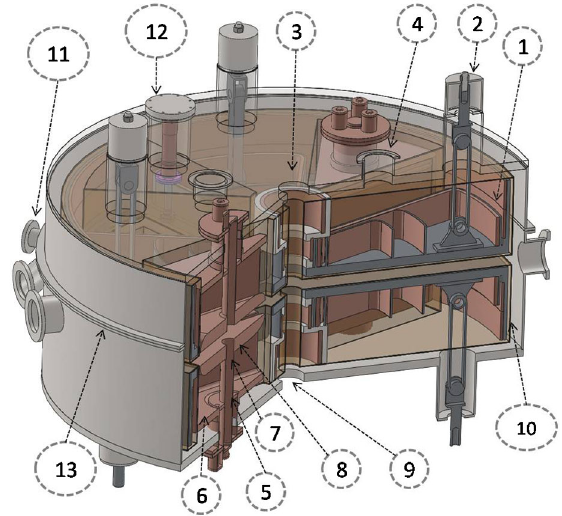
FIG. 16. 3D model of superconducting coil cyclotron, showing different subsystems, as follows: 1. coil cryostat; 2. support link; 3. beam injection port; 4. vacuum port; 5. sliding short between cavity outer and inner conductors; 6. rf liner (outer conductor); 7. dee stem; 8. dee; 9. port for spiral inflector; 10. liquid nitrogen shield; 11. median plane ports for beam extraction, stripper holder, beam diagnostics; 12. port for cryocooler; 13. median plane O-ring